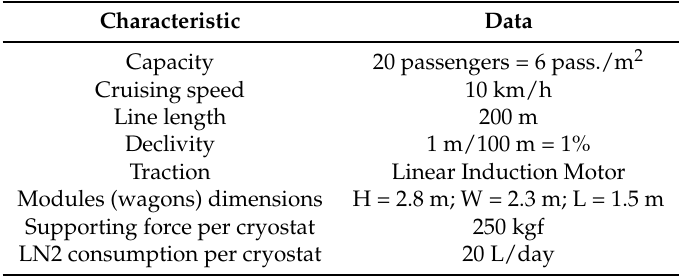
Table 4. MagLev 2 -Cobra experimental prototype system.